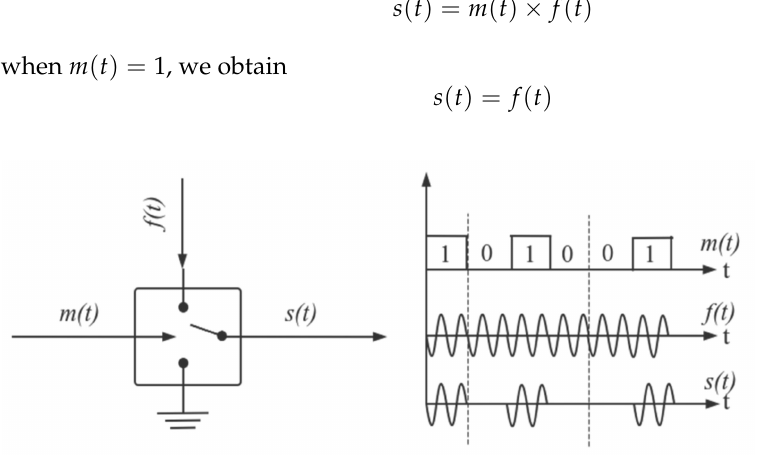
Figure 3. Principle of